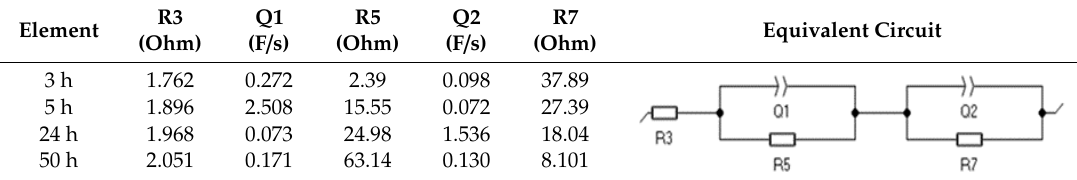
Figure 4. Nyquist plots of HR224 immersed in chloride molten salt at 3, 5, 24, and 50 h. Table 3. Electrochemical parameters obtained for EIS tests in HR224 alloy.